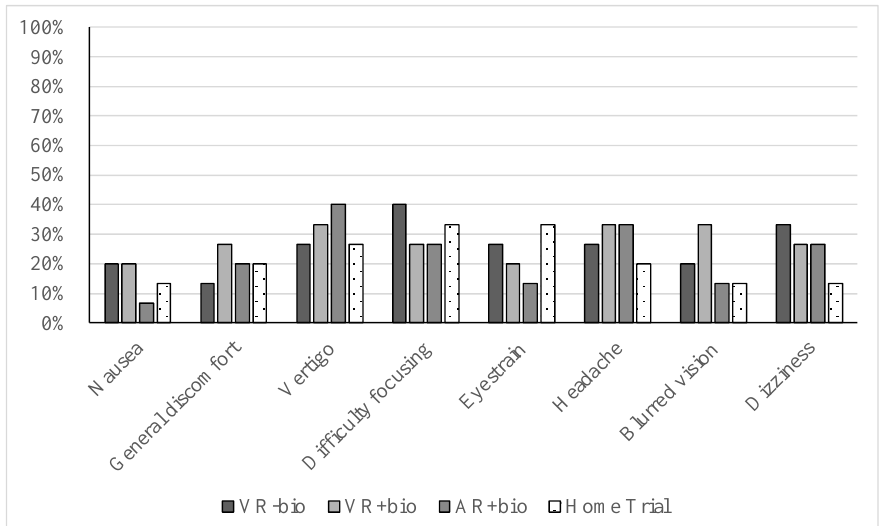
Figure 1. Percentages of participants reporting side effects during experience with XR. Shown in the figure are the percentages of the sample who endorsed experiencing the given side effect item in at least “slightly” during their experience with XR. Percentages shown for VR−bio (immersive virtual reality without integration of biofeedback), VR+bio (immersive virtual reality with integration of biofeedback from a wearable electroencephalogram headset), and AR+bio (augmented virtual reality with integration of biofeedback from a wearable electroencephalogram headset) are based on ratings during the in-clinic experience with XR-based relaxation training. Percentages shown for “home trial” are based on ratings from prospectively trying one of the XR conditions for relaxation training at home.